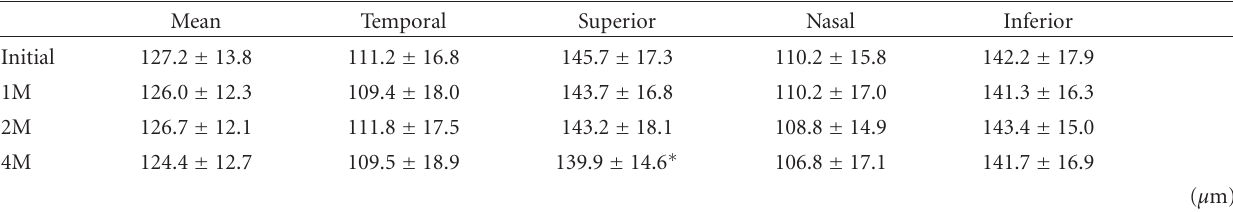
Table 2: Change in retinal nerve fiber layer thickness during glycemic